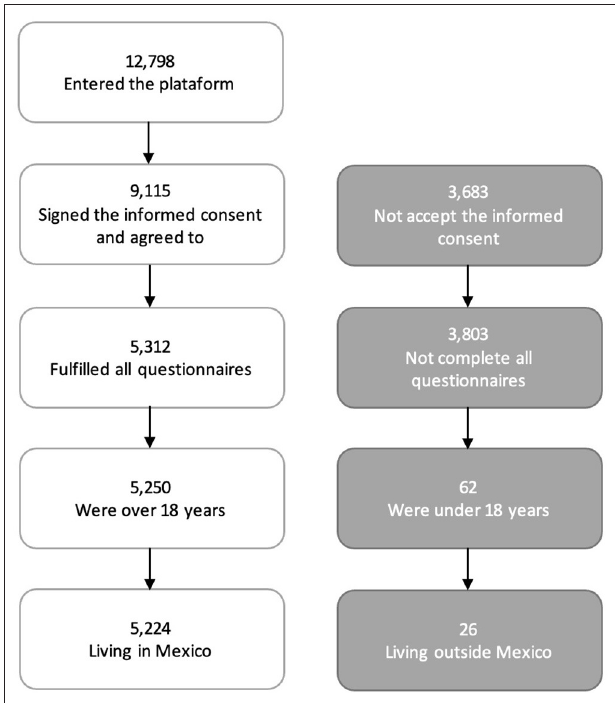
FIGURE 1 | Sample filtering flow